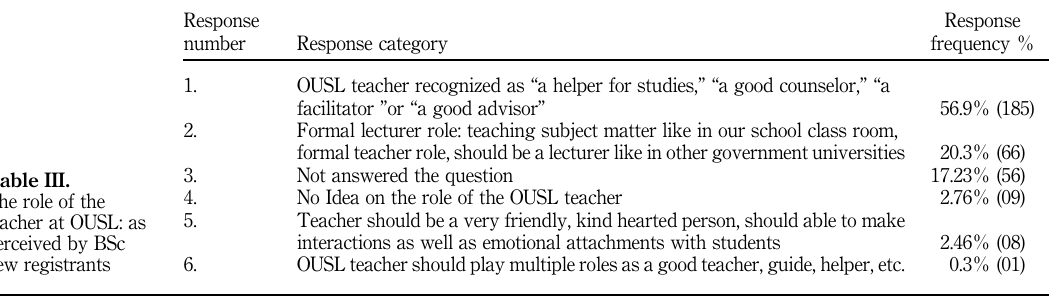
perception of the main instructional media used in OUSL